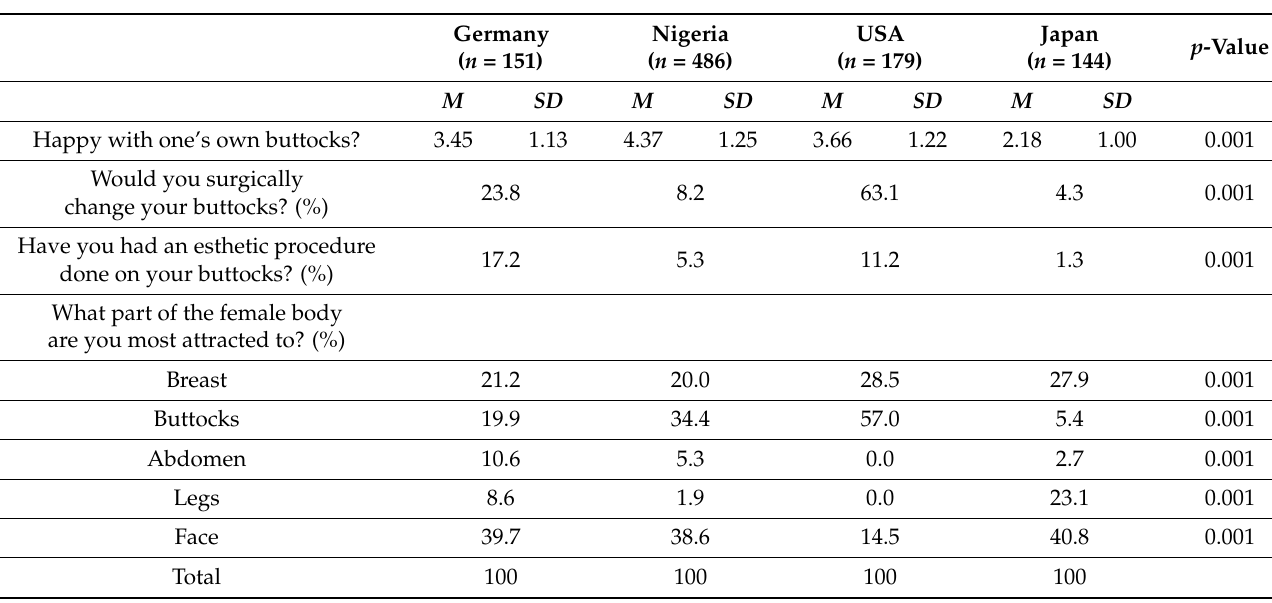
Table 1. Perception of one’s own buttocks in the female participants.